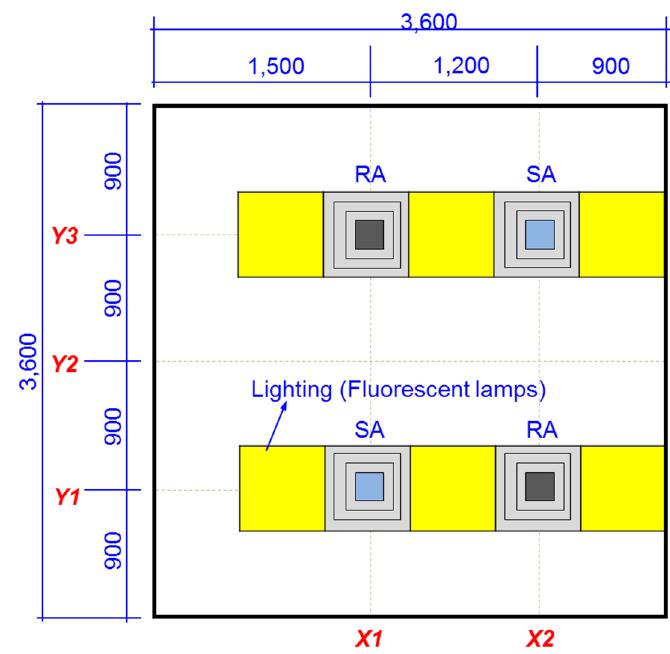
Figure 6. Layout of ceiling equipment (unit: